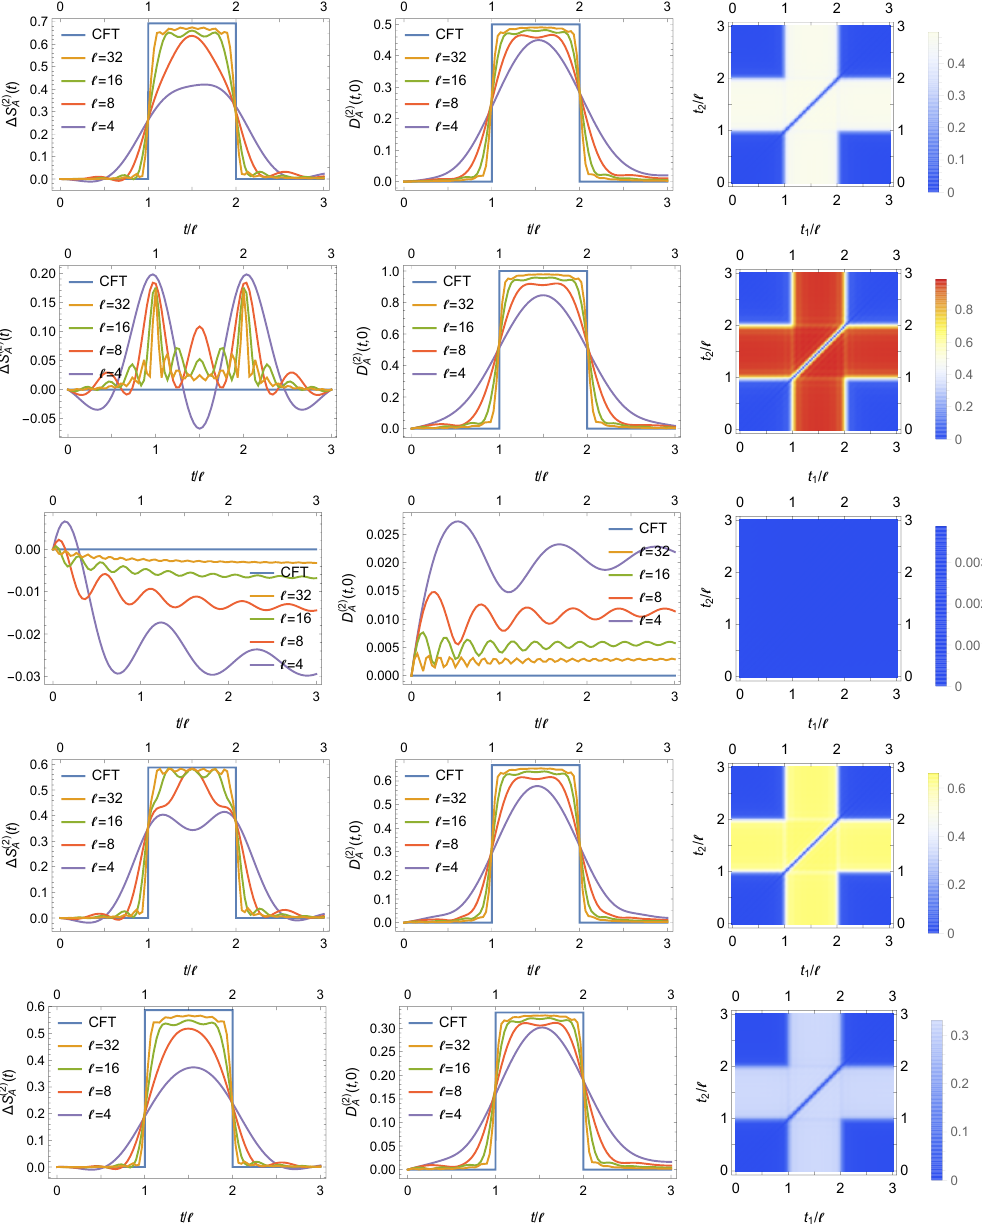
Figure 7 . Local operator quench in the linearized XX spin chain in zero (cid:12)eld. From top to bottom, we consider the states locally excited by a j , e i (cid:30) ( j ) , e i(cid:22) (cid:30) ( j ) , e i (cid:30) ( j ) +e (cid:0) i(cid:22) (cid:30) ( j ) +e (cid:0) i (cid:30) ( j ) , i(e (cid:0) i(cid:22) (cid:30) ( j ) +e (cid:0) i (cid:30) ( j ) (cid:0) e i(cid:22) (cid:30) ( j ) ) with respectively q = 1 ; 0 ; 1 ; 1 ; 2 (see table 2). We focus on second R(cid:19)enyi entropy and 2 3 3 Schatten distance. In the 3rd column we report the color plots of the Schatten 2-distance between RDM at generic times D A ( t 1 ; t 2 ) with ‘ = 32.